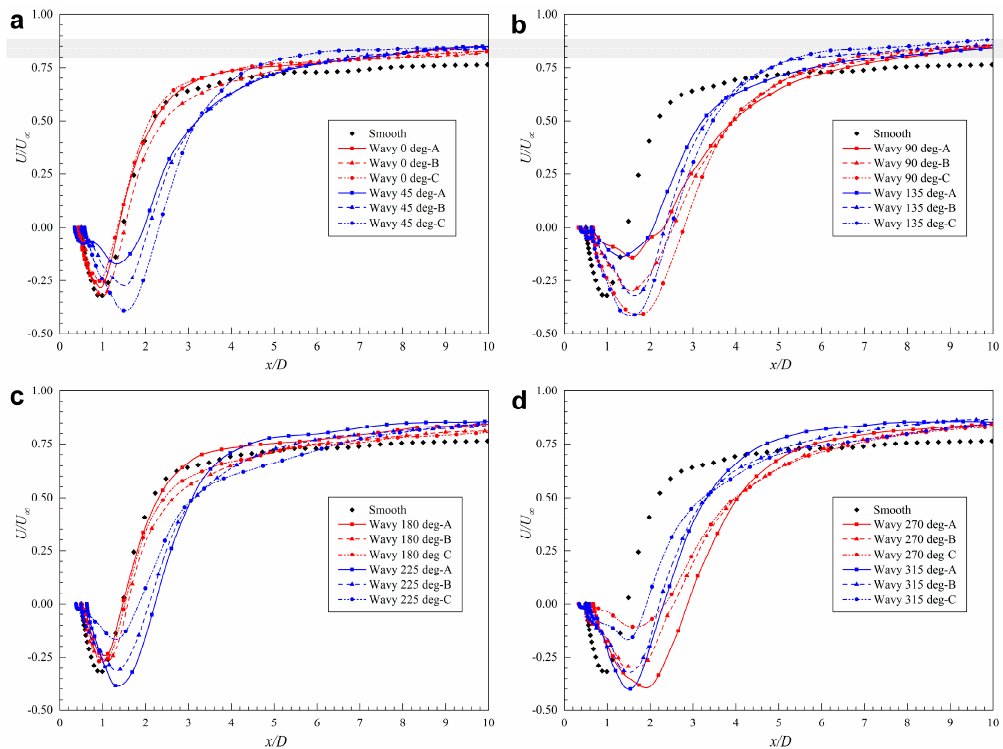
Figure 6. Comparison of the average streamwise velocity distributions of the smooth cylinder and wavy cylinder A1 at eight rotation angles. Here, ( a ) θ = 0° and 45°; ( b ) θ = 90° and 135°; ( c ) θ = 180° and 225°; ( d ) θ = 270° and 315°.